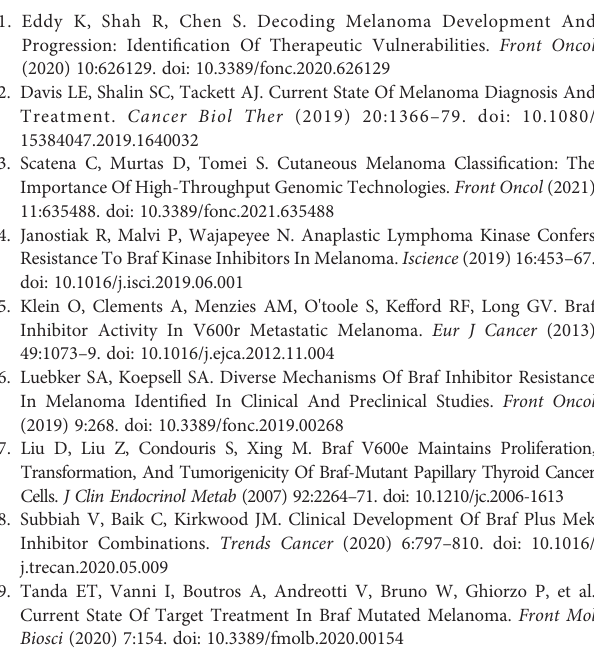
sequencing. Supplementary Table 3 | Integration of ATAC sequencing and RNA sequencing data with signi fi cantly altered chromatin accessible regions aligning with gene expression changes in in M229-Par and M229-Res